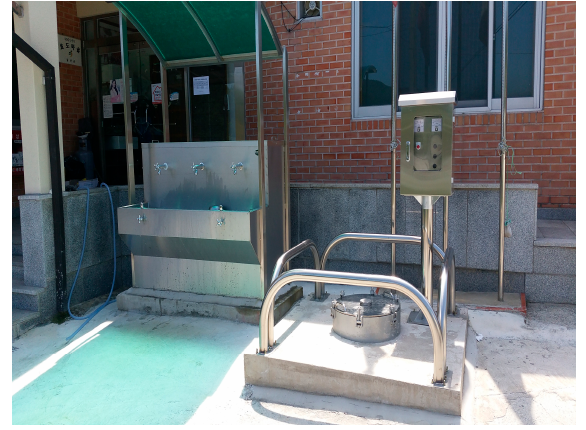
Figure 3. Installation of public drinking water wells.